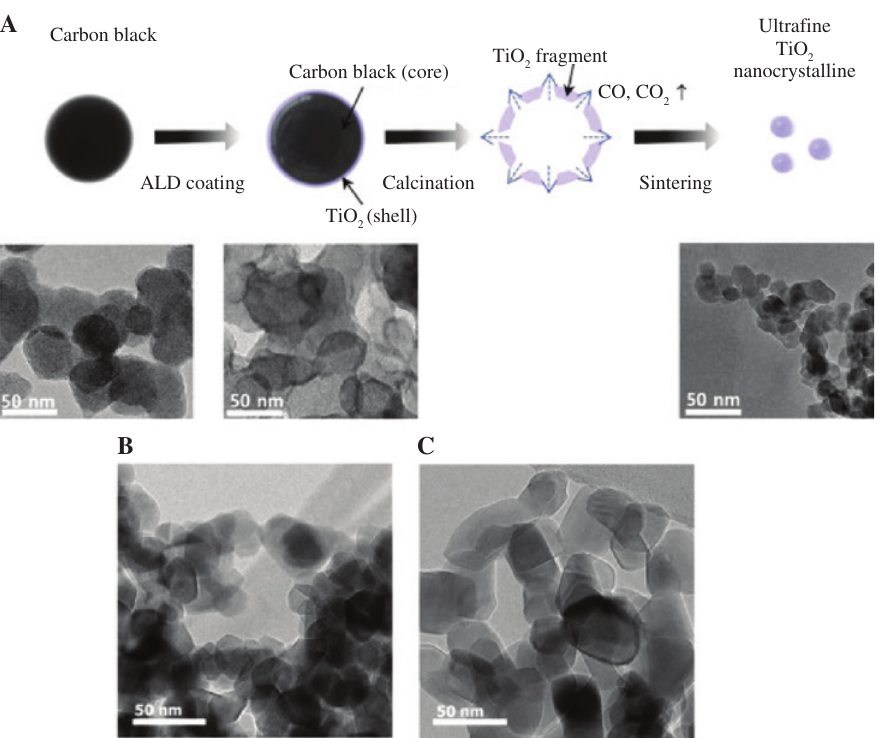
nanocrystalline anode synthesis. (Down) SEM 2 produced from the carbon black encapsulated by 2